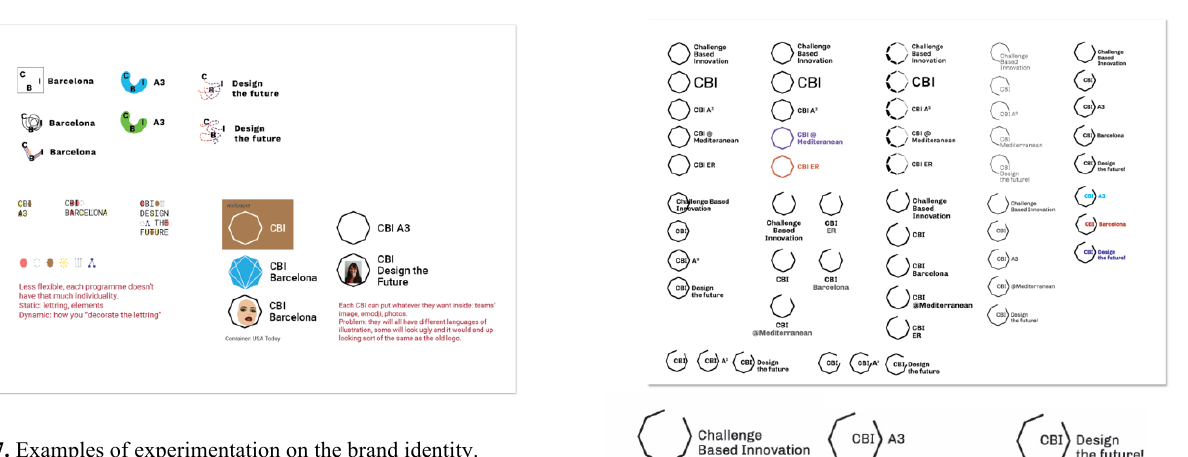
Fig. 7. Examples of experimentation on the brand identity.